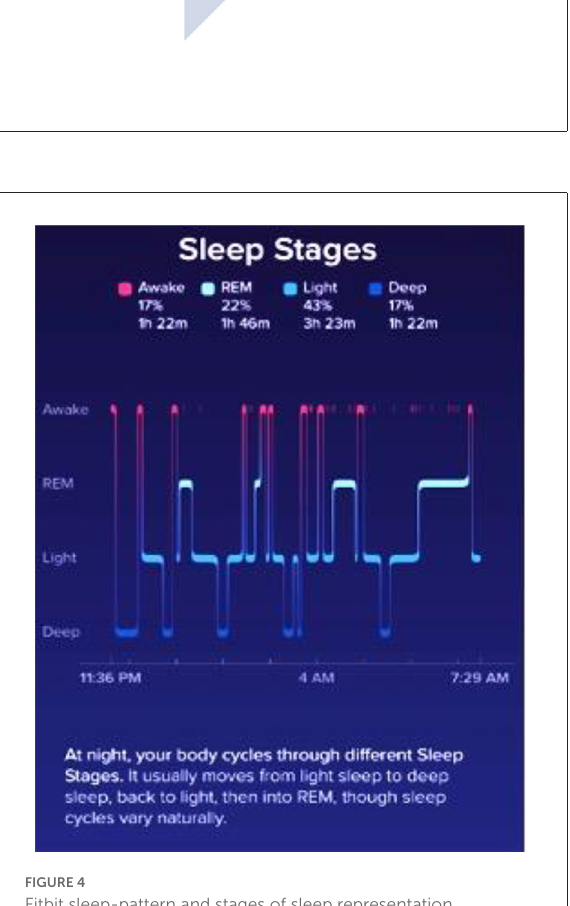
FIGURE4 Fitbit sleep-pattern and stages of sleep